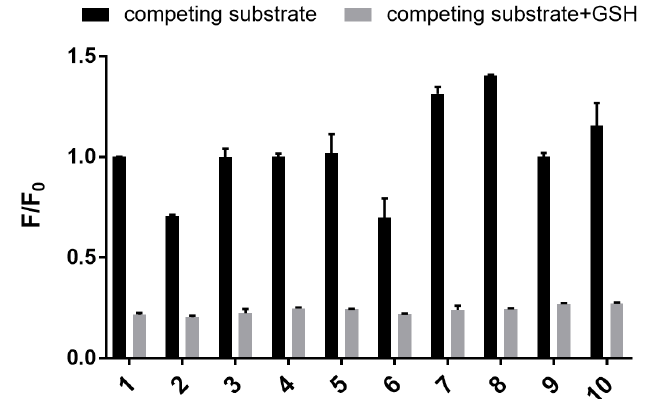
Figure 7. Bar graph showing fluorescence of 1 (50 μ M) in the presence of a range of biologically relevant substrates: 1. blank; 2. glutathione disulfide (GSSG); 3. Cys; 4. Asp; 5. Glu;